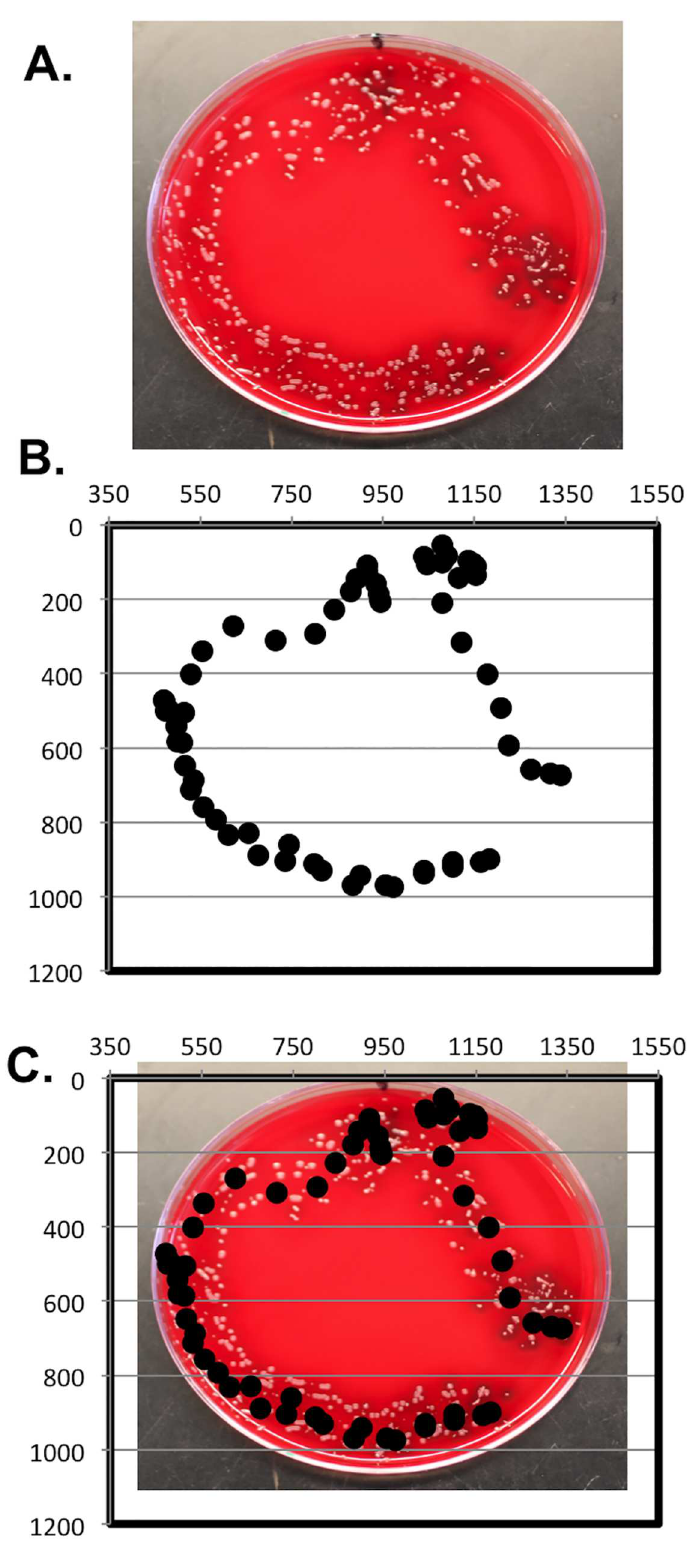
Fig 10. Ant transmitted B . bronchiseptica after exposure to amoeba. (A) B . bronchiseptica growth on a Bordet-Gengou (BG) agar plate with streptomycin inoculated by an ant carryingamoebae.(B) Scatter